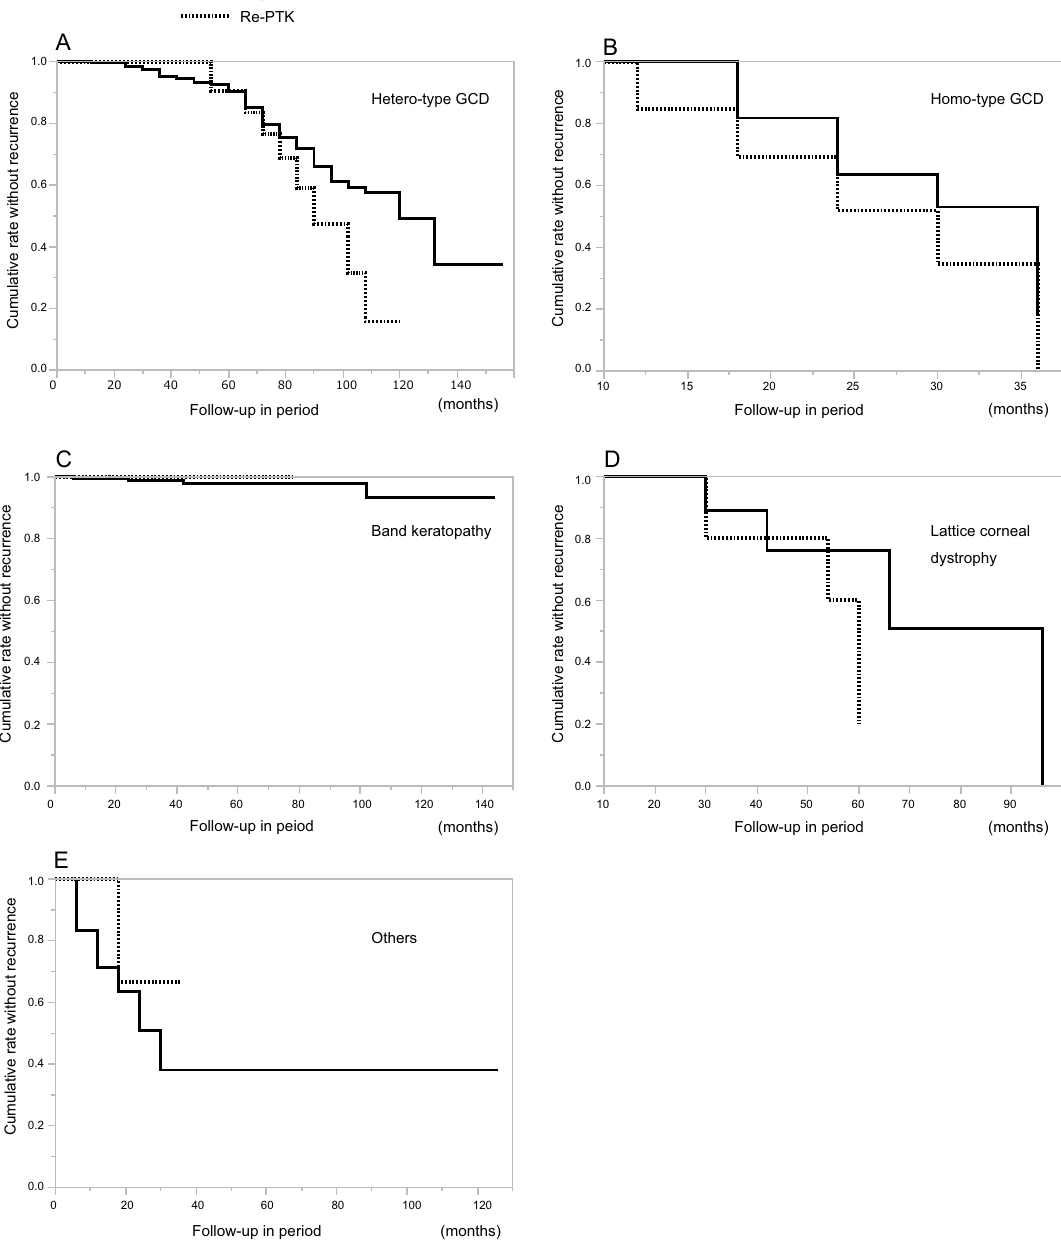
Figure 3. Graph showing the survival curve of the non-recurrence of disease after re-PTK compared with initial PTK among the 5 groups. There was no difference in the recurrence rate after re-PTK and initial PTK among the 5